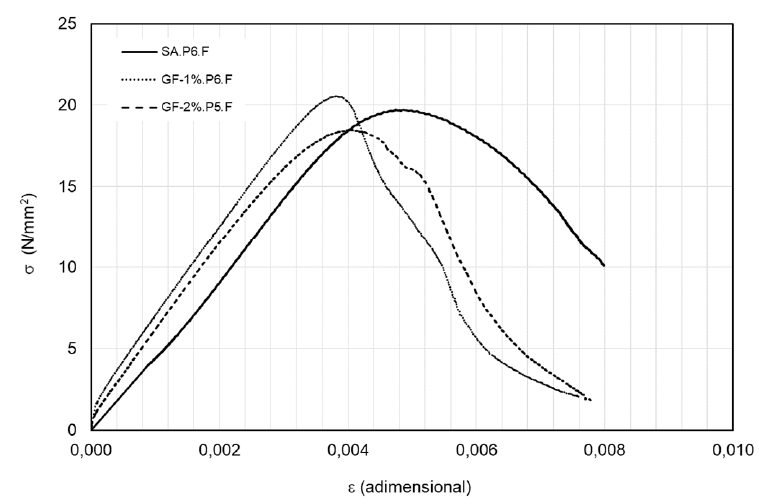
Figure 6. Evolution of strength ( σ ) in relation to strain ( ε ) in test pieces without addition, with percentages of 1% and 2% of polypropylene fibers and with percentages of 1% and 2% of steel fibers, after undergoing direct fire testing.